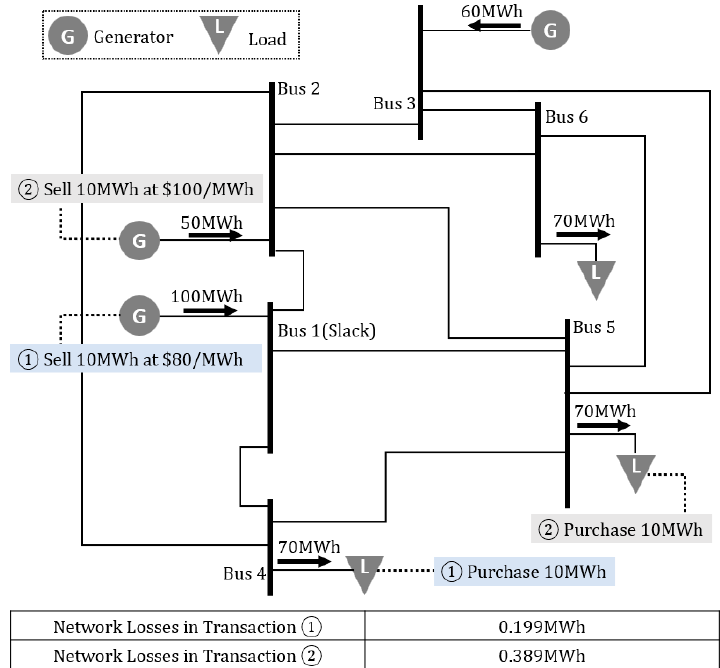
Figure 3. 6-bus network example of the loss-guided trading framework.